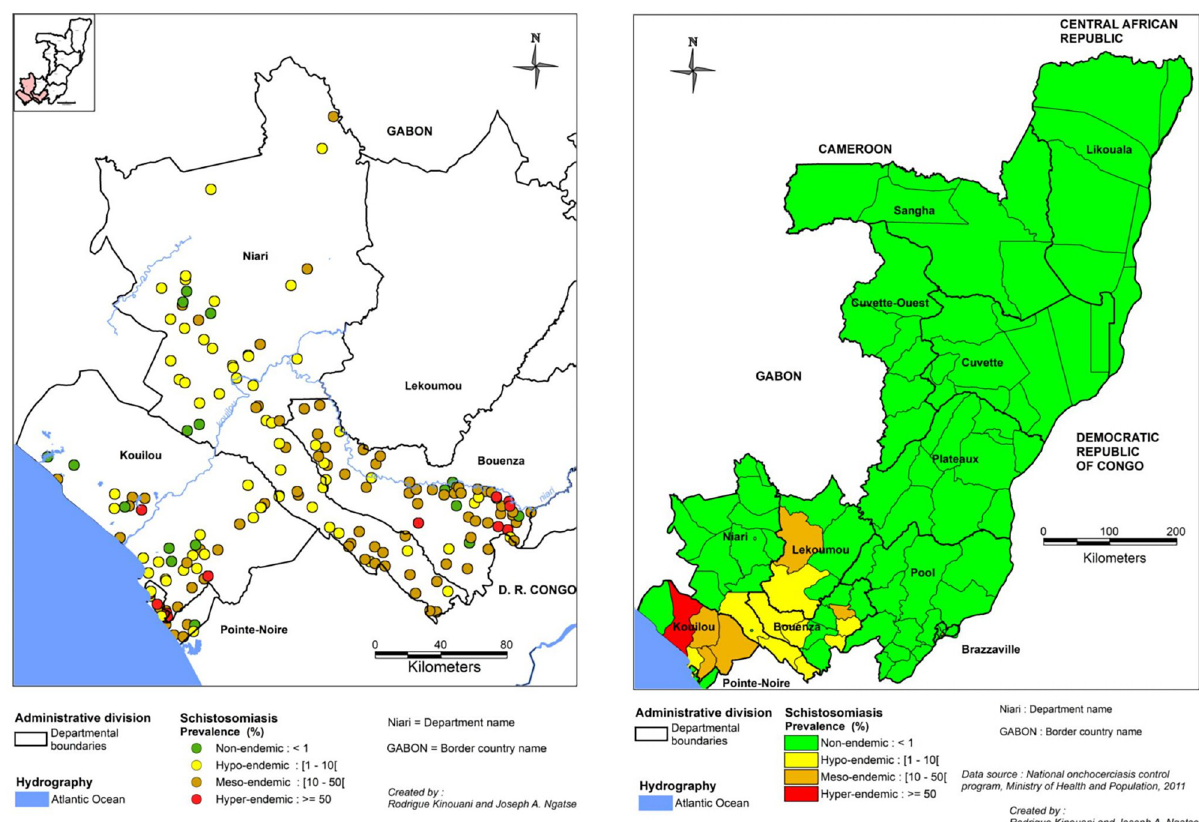
Fig 9. Distribution of schistosomiasis in the Republic of the Congo. The left panel reports results from all epidemiological surveys conducted between inception to 1987 (last known published study); the right panel reports the most recent results, from a 2011 survey conducted by the PNLO. The map was created with MapInfo 8.5 (Geographic Information System, http://www.precisely.com). The base layer used of the map was created by the « Laboratoire Population Environnement De´veloppement » (LPD, UMR 151 AMU-IRD) (https://www.lped.fr/-observatoires-societe-environnement-. html) under the supervision of the Ministry of Health and Welfare of the Republic of